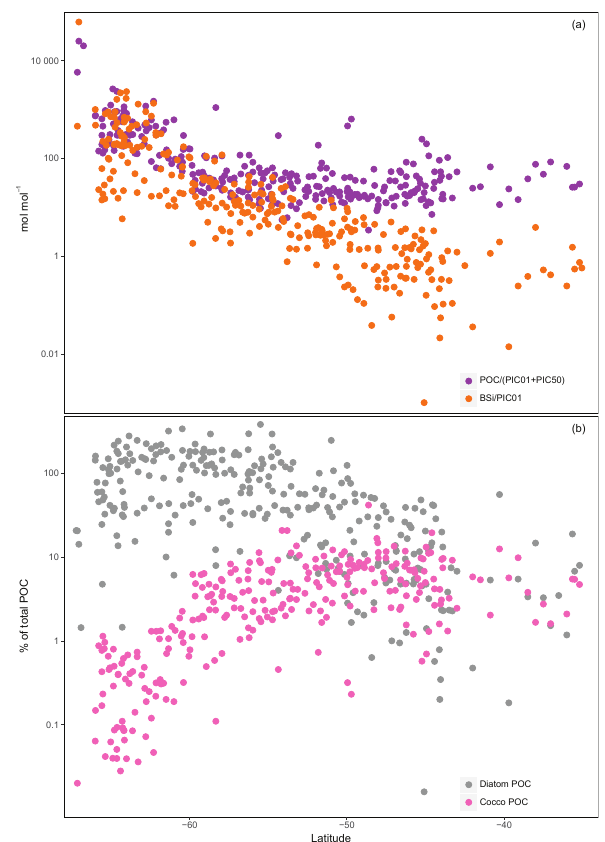
Figure 4. Latitudinal variations in the dominance of diatoms versus coccolithophores and their contributions to total POC for results combined from all voyages: (a) BSi / PIC01 and POC / (PIC50 + PIC01) ratios; (b) percent contributions to total POC attributable to diatoms (assuming POC/BSi = 3.35) and coc- colithophores (assuming POC / PIC01 =